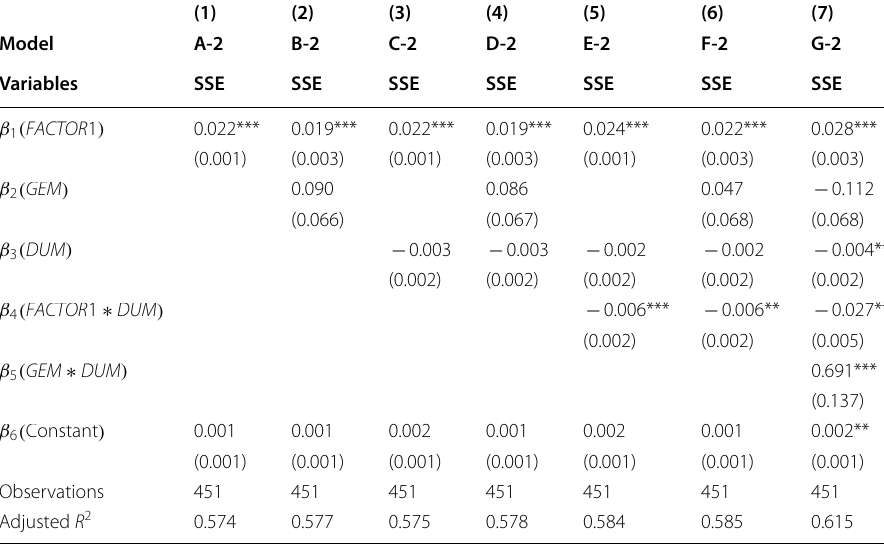
Robust standard errors in parentheses. *** p < 0.01, ** p < 0.05, * p <